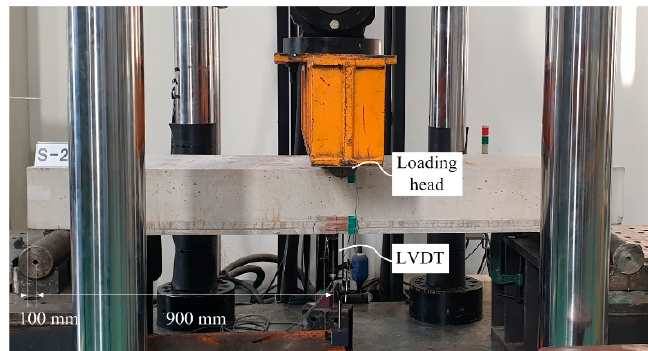
Figure 14. Full-scale flexural test setup and instrumentation.